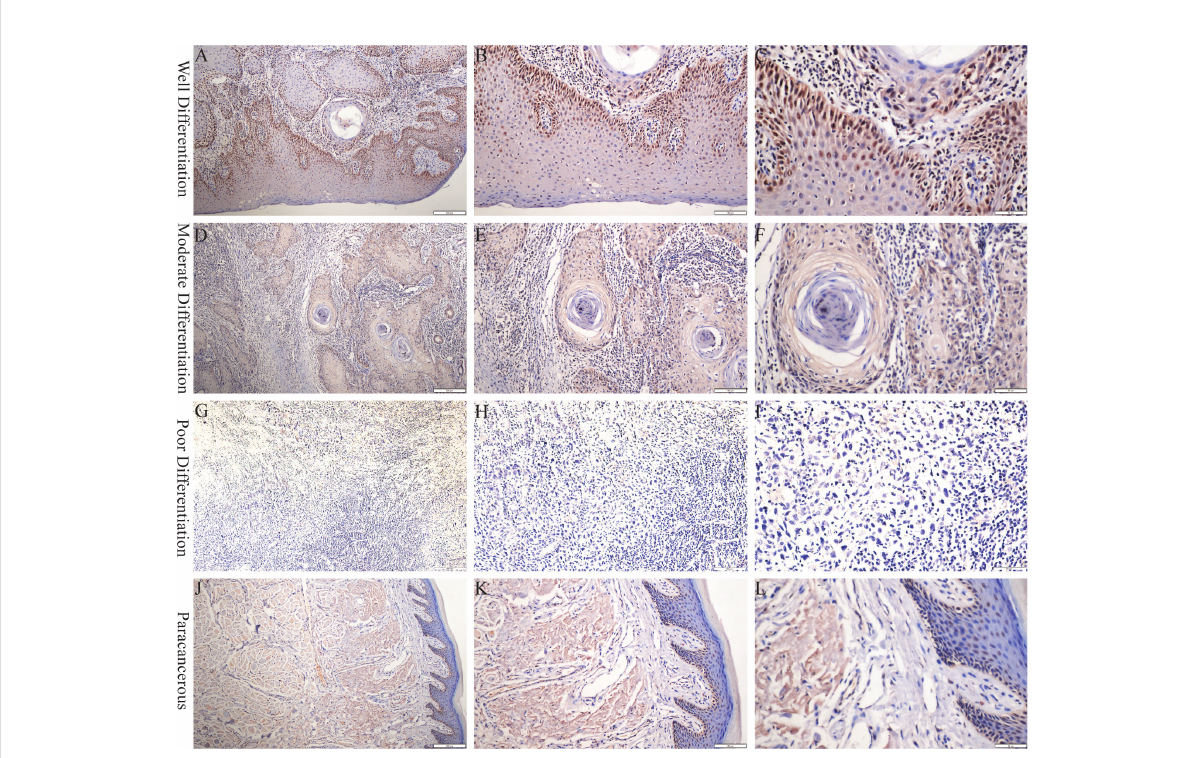
FIGURE 2 Immunohistochemical staining was performed to detect the expression of PCNP at different stages of OSCC. (A – C) Well differentiation OSCC in 10×, 20×, 40×. (D – F) Moderate differentiation OSCC in 10×, 20×, 40×. (G – I) Poor differentiation OSCC in 10×, 20×, 40×. (J – L) Paracancerous samples in 10×, 20×, 40×.